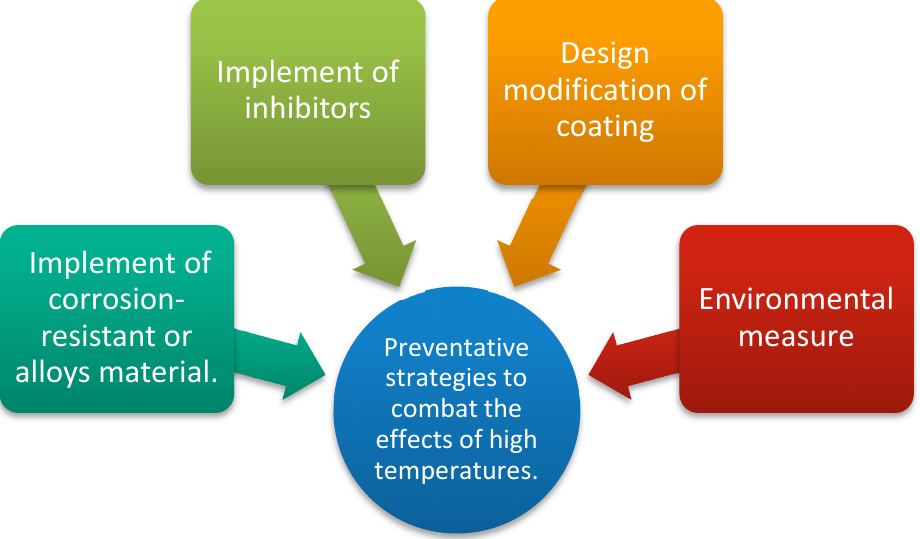
Figure 21. Preventative strategies to combat the hot-corrosion effects at high temperatures.